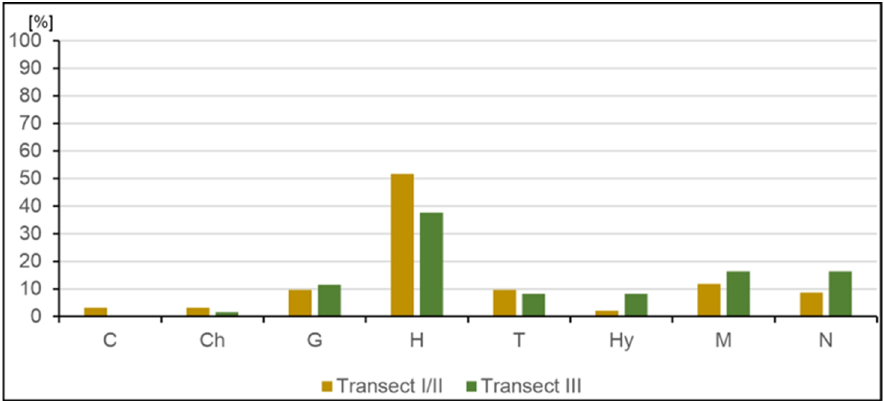
Figure 6. Percentage share of plant life forms: N—nanophanerophyte, M—megaphanerophyte, Hy—hydrophyte, T—therophyte, H—hemicryptophyte, G—geophyte, Ch—chamaephyte, C—herbaceous chamaephyte.